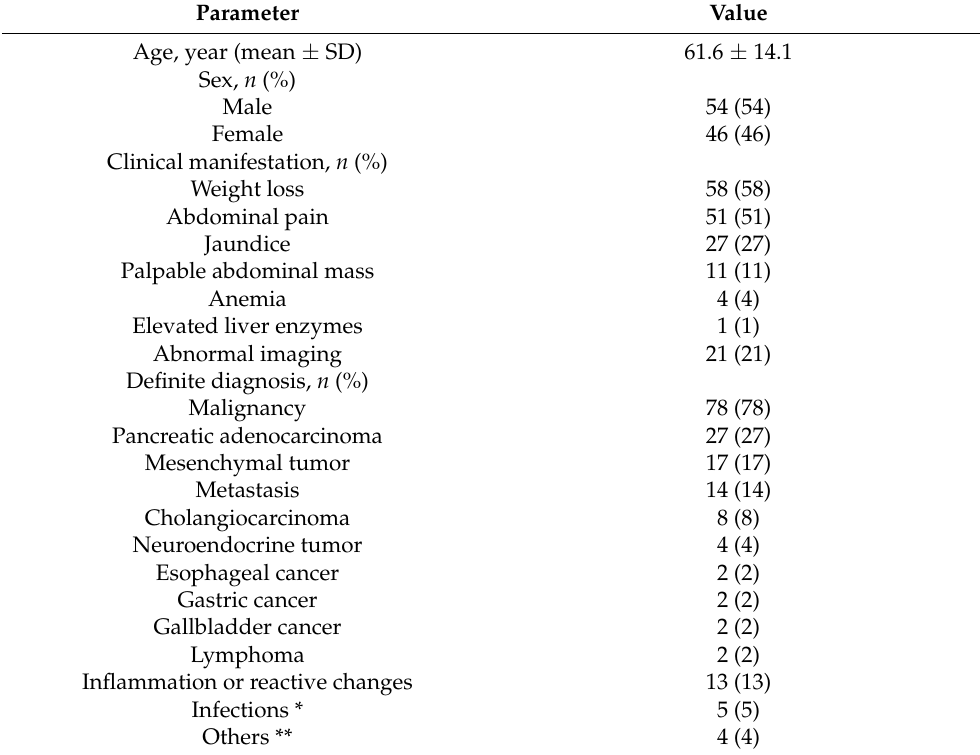
Table 1. Patient characteristics of the study